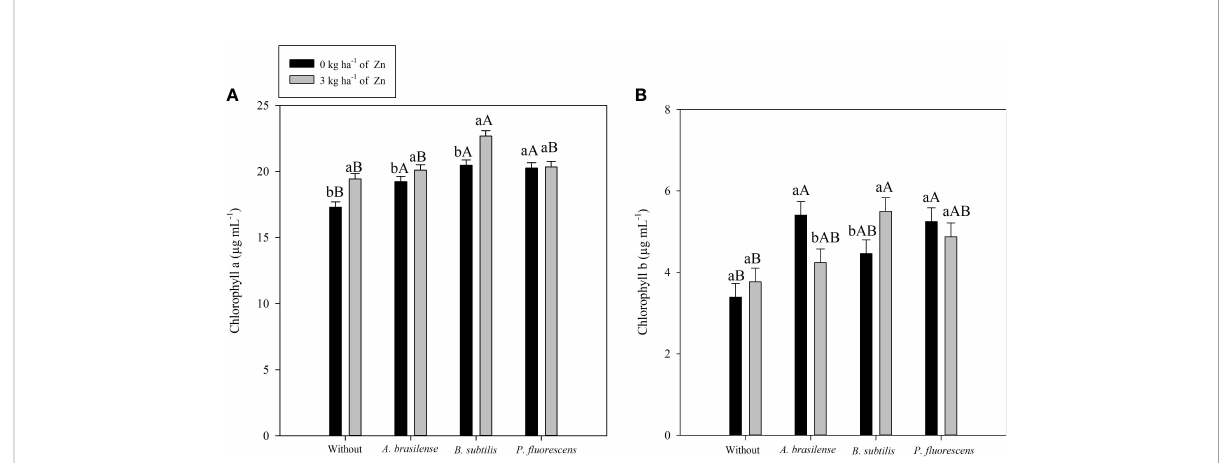
FIGURE 5 Concentrations of chlorophyll a in 2020 – 1 (A) and chlorophyll b in 2019 – 20 (B) of maize leaf as a function of plant growth-promoting bacteria with or without foliar zinc oxide (ZnO) application. Without = control (no inoculation). The uppercase letters compare interactions of inoculations within each dose offoliar nano-ZnO application and the lowercase letters are used to compare interactions offoliar zinc doses (presence and absence) within each inoculation treatment. The identical alphabetic letters do not differ from each other by Tukey ’ s test ( p < 0.05) for foliar ZnO doses and inoculations in the 2019 – 20 and 2020 – 1 cropping seasons. Error bars indicate standard error of the mean ( n = 4